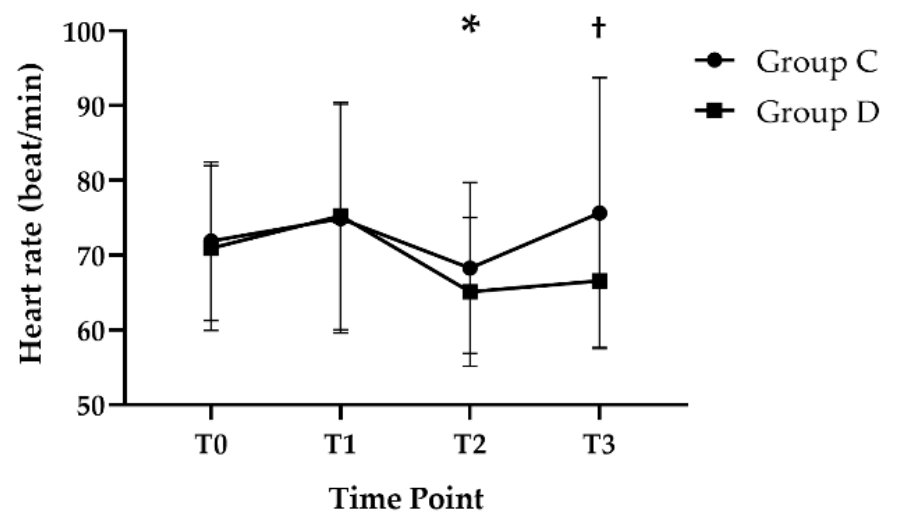
Figure 3. Change in heart rate during the study period. Error bars represent standard deviation. * p